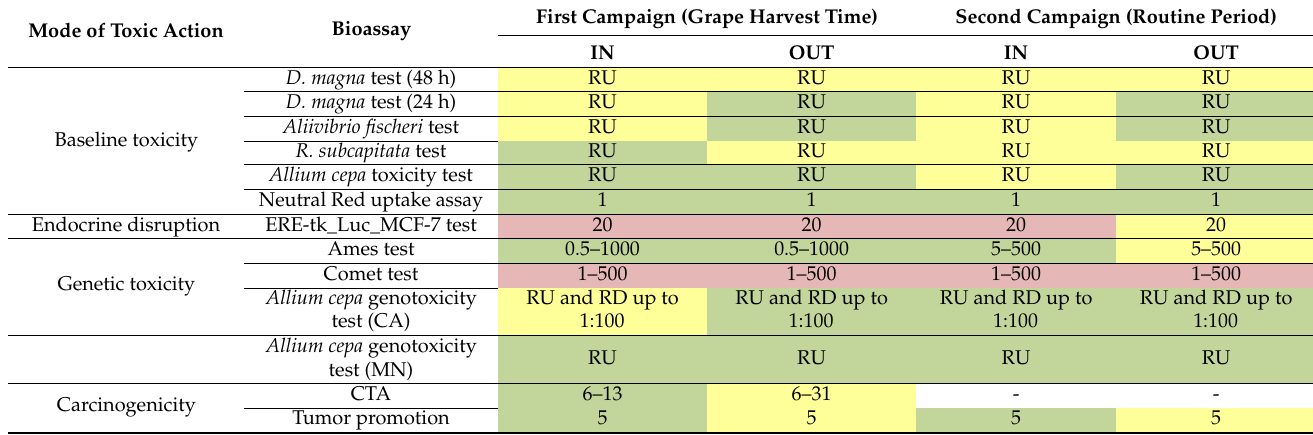
Table 12. “Traffic-light” representation of results for WWTP B. The REF value or type of sample (RU = raw undiluted, RD = raw diluted) used to establish the color of each assay are